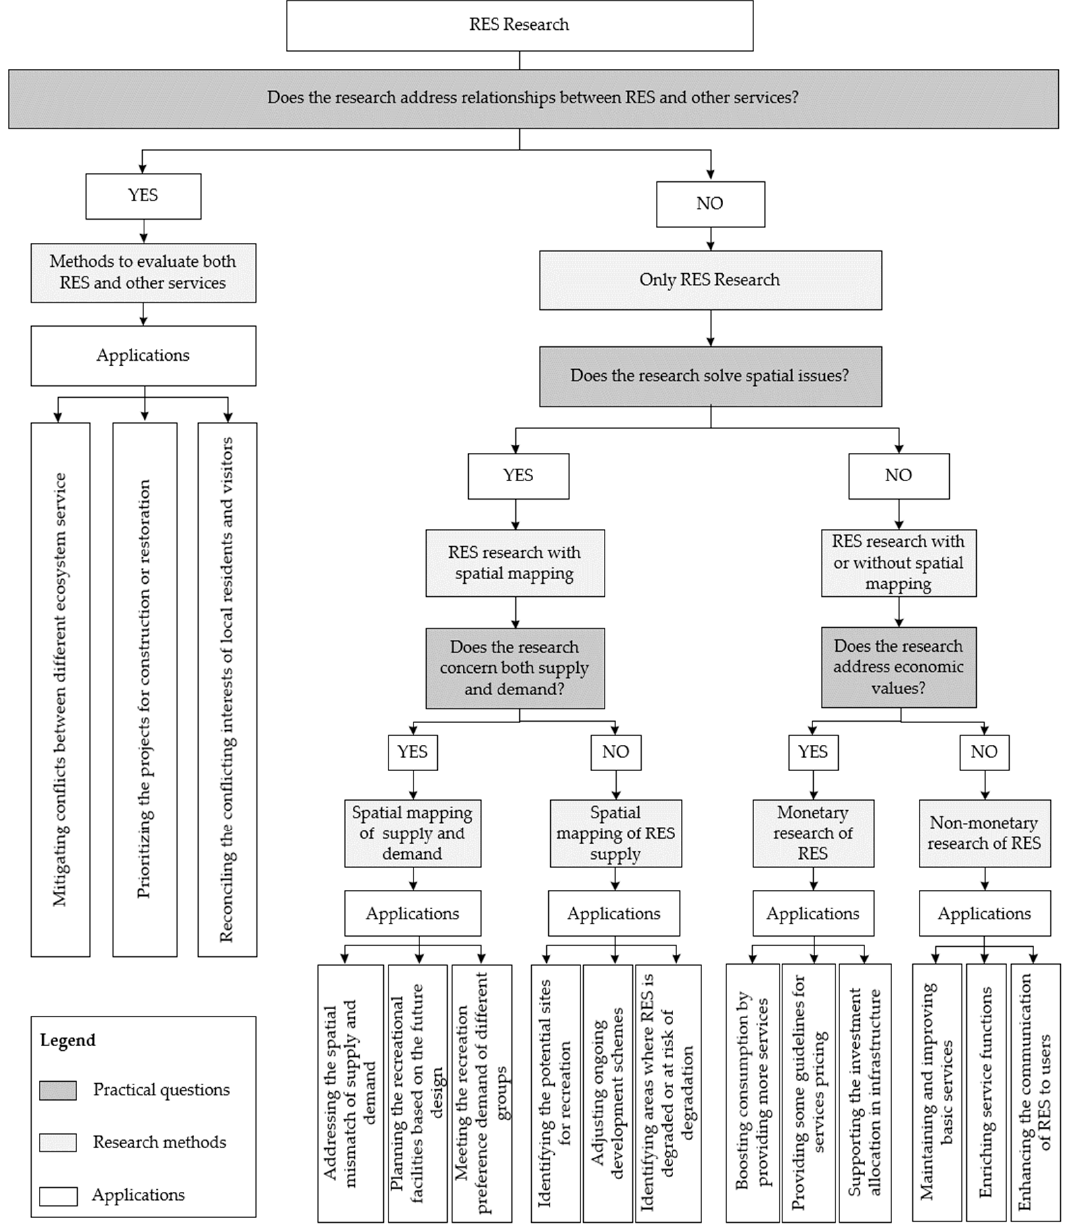
Figure 5. A framework to ensure RES research can be applied.